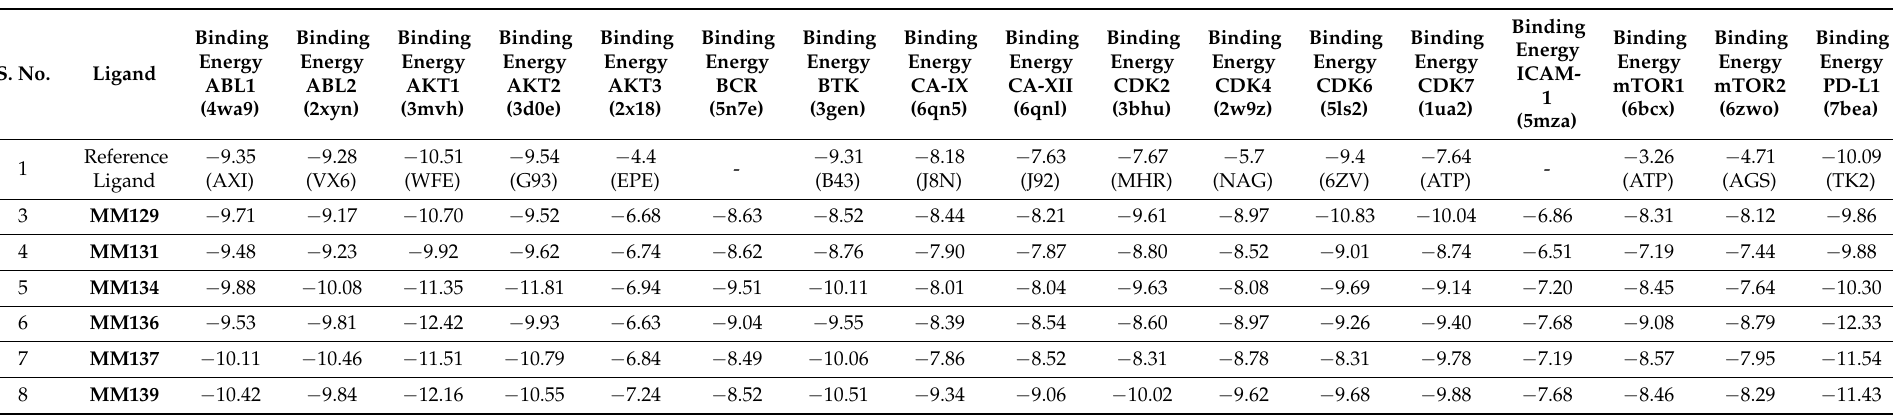
Table 4. Molecular docking results of six triazine sulfonamide analogs as well as all the reference